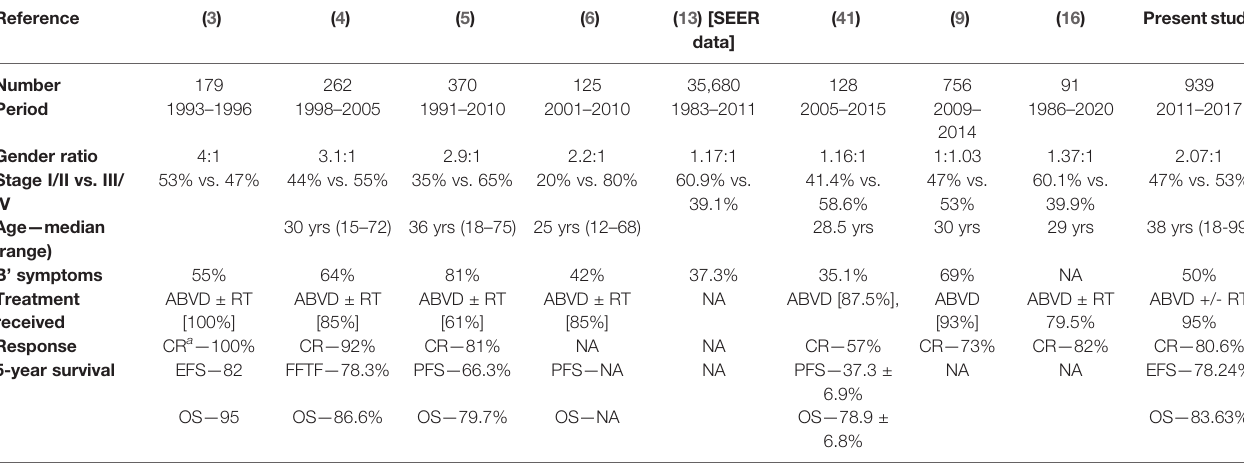
TABLE 4 | Comparison of Hodgkin lymphoma outcomes from Indian studies with SEER